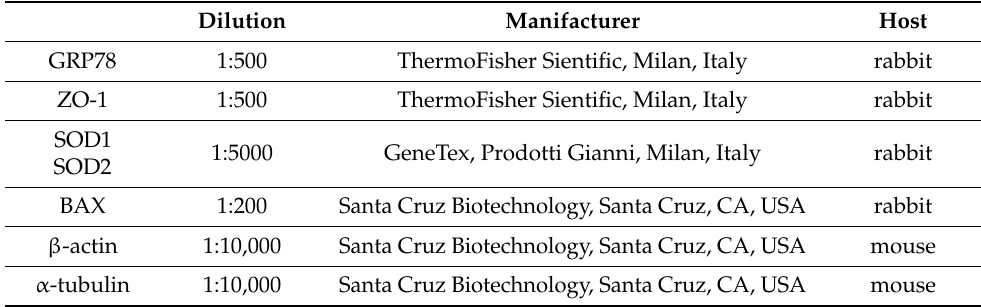
Table 1. Primary antibody for Western blotting